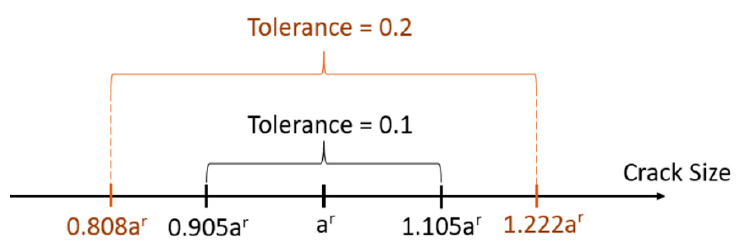
Figure 13. The acceptable ranges for the prior cracks.